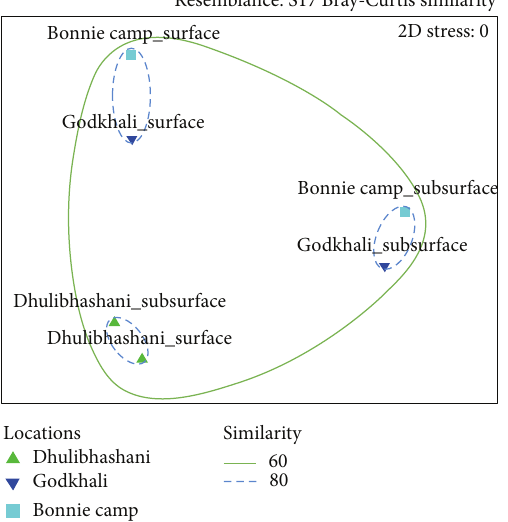
Figure 3: Archaeal community compositional structure in the sediments of Sundarbans indicated by Nonmetric Multidimensional Scaling (NMDS) using Bray-Curtis distance. Gene abundance data was transformed based on presence/absence before creating Bray- Curtis resemblance matrix for NMDS analysis (showing similarity based on community composition